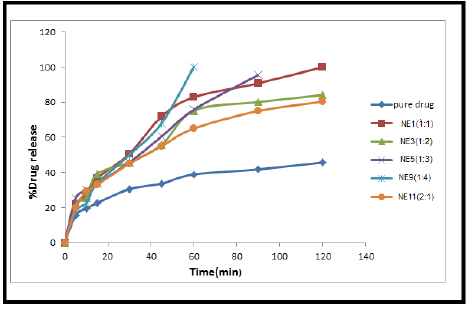
Figure 4. Effect surfactant:cosurfuctant ratio on release profile of isradipine nanoemulsion (NE1,NE3,NE5,NE9,NE11) and pure isradipine .